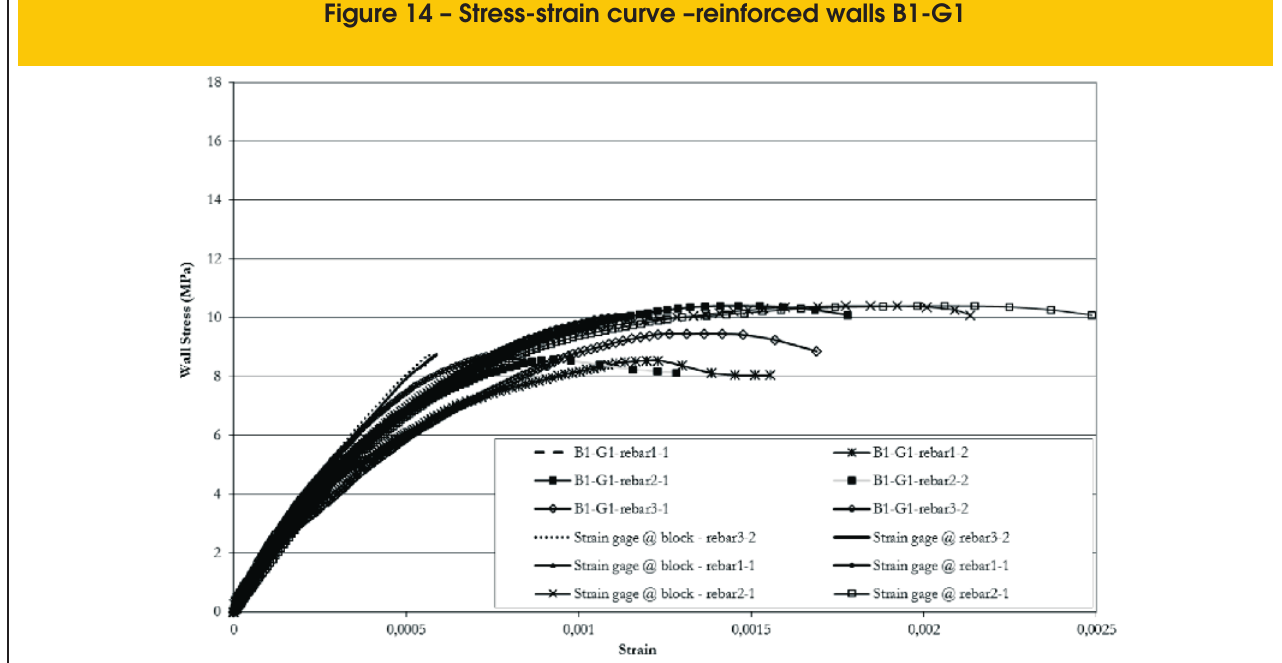
Figure 14 – Stress-strain curve –reinforced walls